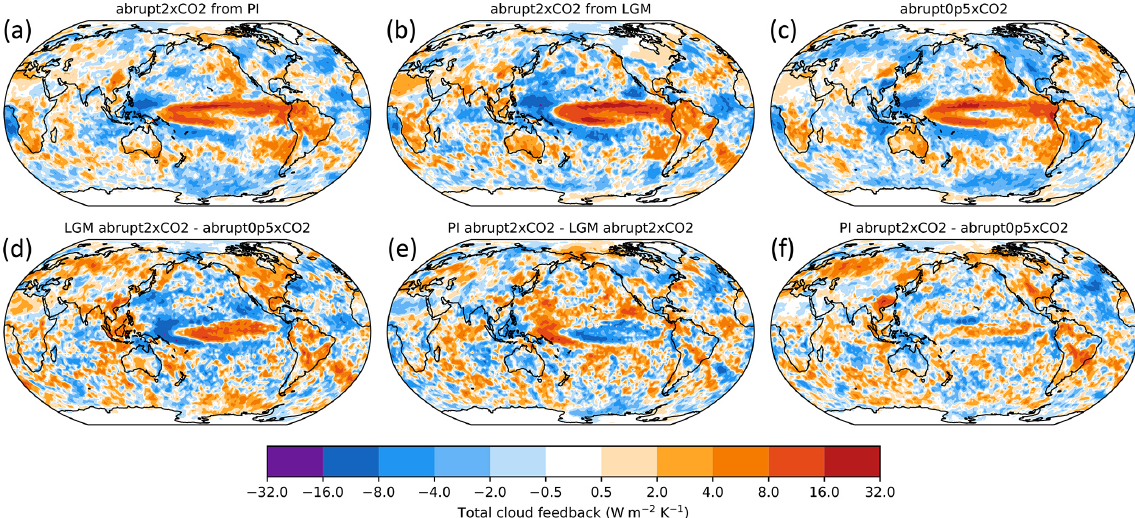
Figure 9. Cloud feedback parameters computed with the PRP method in three simulations performed with MPI-ESM1.2-LR (a–c) and differences in cloud feedbacks between the three simulations (d–f) . (a) abrupt2 × CO 2 from pre-industrial conditions (560ppm), (b) abrupt2 × CO 2 from LGM conditions (380ppm), (c) abrupt0p5 × CO 2 from pre-industrial conditions (180ppm), (d) LGM-abrupt2 × CO 2 minus